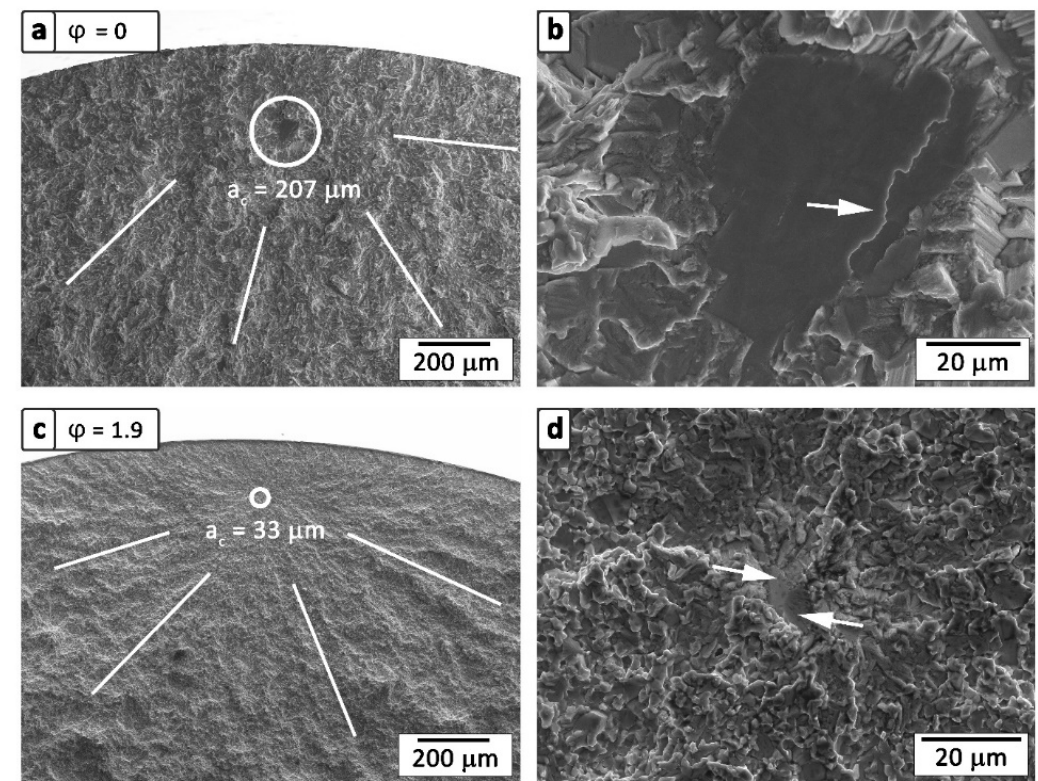
Figure 4. Fracture mirrors including the critical crack length a c as well as crack initiation sites of selected, fractured rotating bending test specimens taken by SEM in secondary electron (SE) mode. A representative fracture surface of an undeformed specimen ( a , b ) appears to be rougher in contrast to the deformed specimen ( c , d ). It shows a cleaved ( α 2 / γ ) col as an initial crack, including a translamellar step, which is marked by an arrow in ( b ). In ( c , d ), a hot-extruded sample with a degree of deformation of φ = 1.9 is depicted. Here, coarse γ -grains with different angles to the image plane act as initial cracks and are highlighted in ( d ) by white arrows.